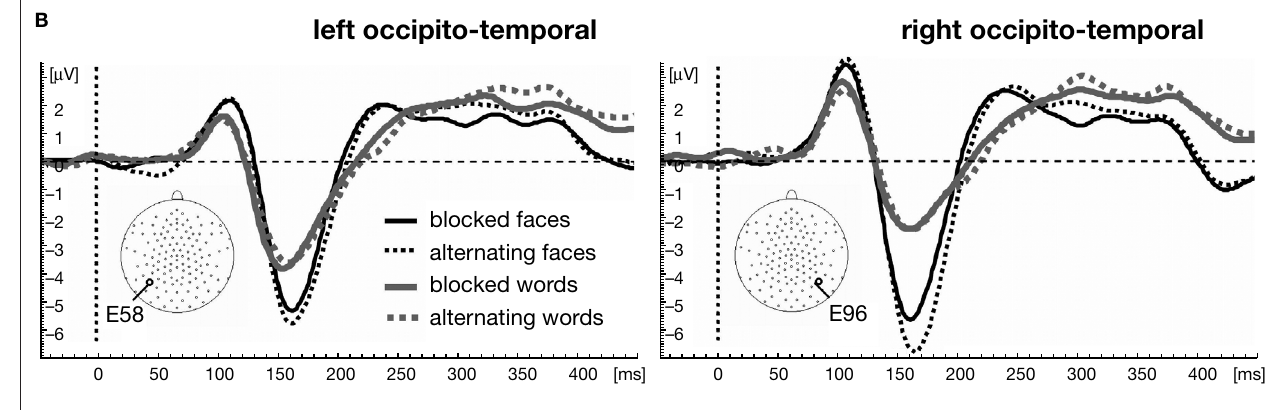
FIGURE 3 | Topographic ERP maps and occipito-temporal waveforms. (A) The segment identifi ed by the TANOVA (168–188 ms) shows stronger N170 ERP maps for faces (top left two columns) than for words (bottom left two columns). As indicated by the t-maps, a habituation effect occurred only for the faces (top right), but not for the words (bottom right). The habituation effect was right-lateralized for the negative pole and left-lateralized for the positive central counterpart of the face N170 (the vertex positive potential,